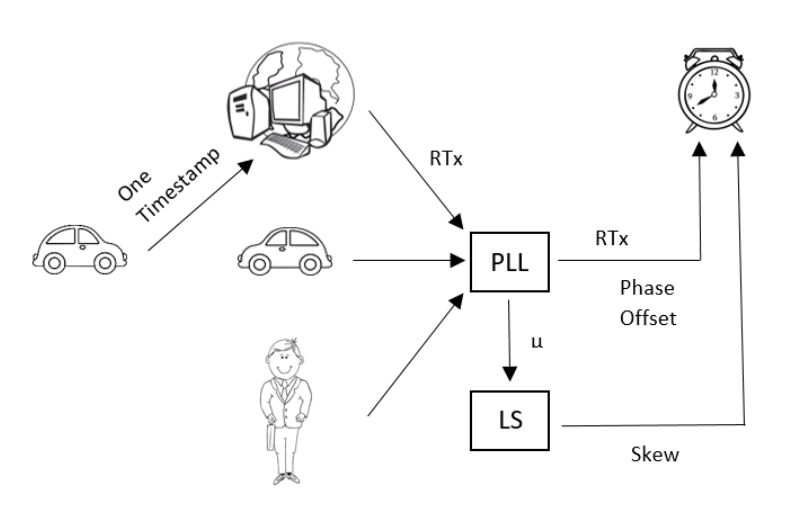
Figure 1. Single-timestamp skew-correction (STSC)